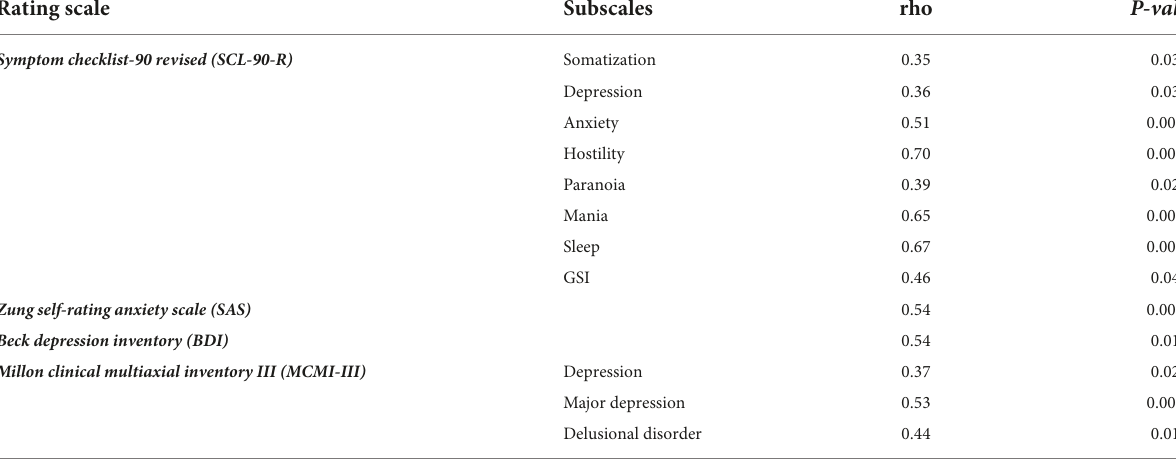
TABLE 2 Correlation coefficients (Spearman rho) between RSA and psychological assessment. Rating